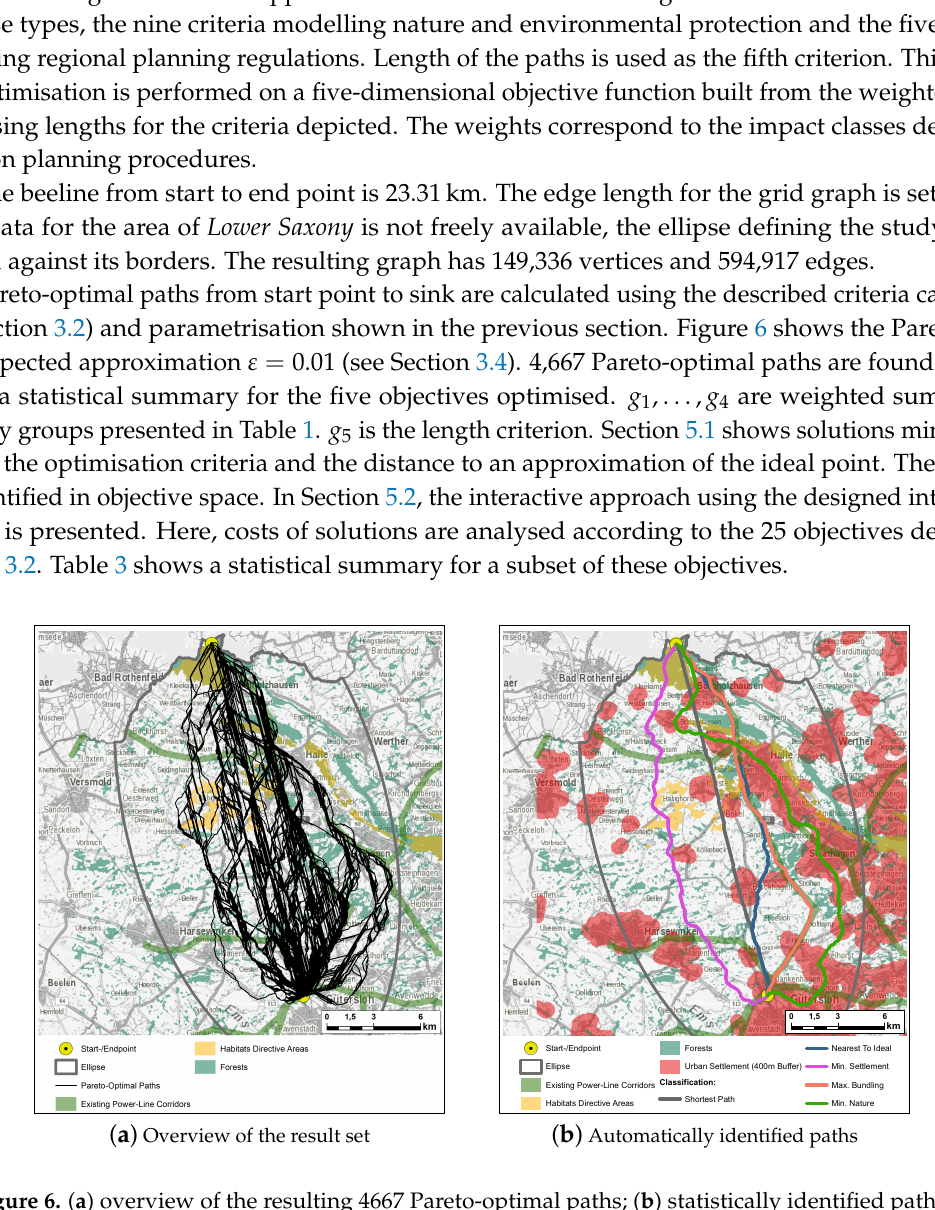
Figure 6. ( a ) overview of the resulting 4667 Pareto-optimal paths; ( b ) statistically identified paths of interest. Visualisation of the paths minimising each of the five criteria. The path with minimal length is also the path with minimal crossing of priority areas (regional planning